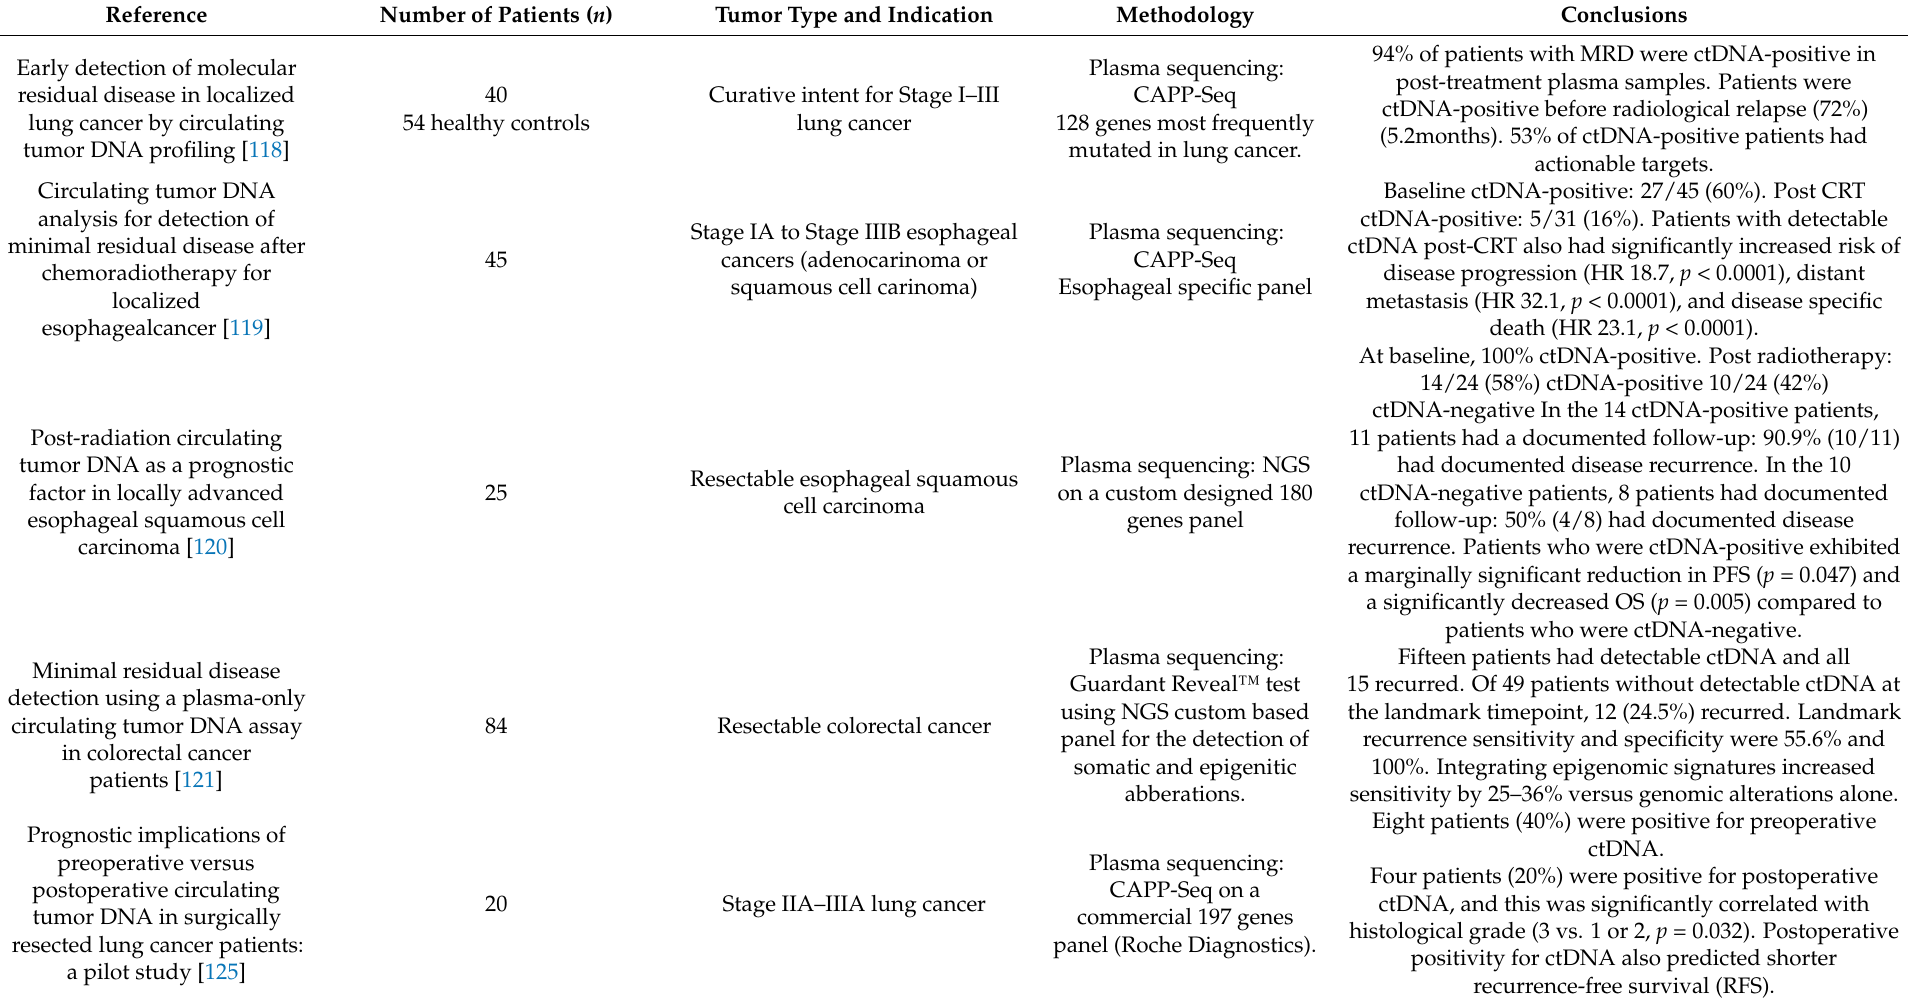
Table 2. Non-exhaustive list of published trials with non-personalized methods to identify MRD through ctDNA